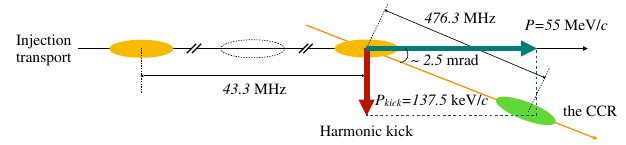
FIG. 2. A schematic view of the kicker. The black arrowed line is injection transport, while the yellow line is the CCR. The kick is represented by a big red downward arrow. The yellow ellipses are injected bunches, while the green ellipse is a recirculating bunch in the CCR. The dotted transparent ellipse is an empty bucket reserved for the